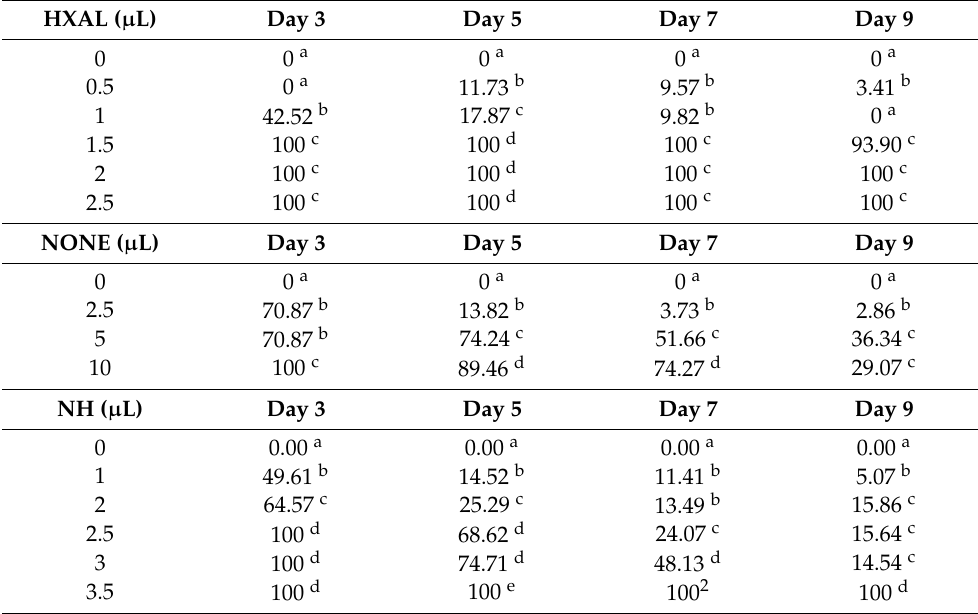
Table 2. Inhibition percentage (%) of B. cinerea exposed to the vapor generated by diverse amounts of trans 2-hexenal (HXAL), 2-nonanone (NONE), and their 1:1 mixture (NH) on days 3, 5, and 7 and after two days of being exposed to air (day